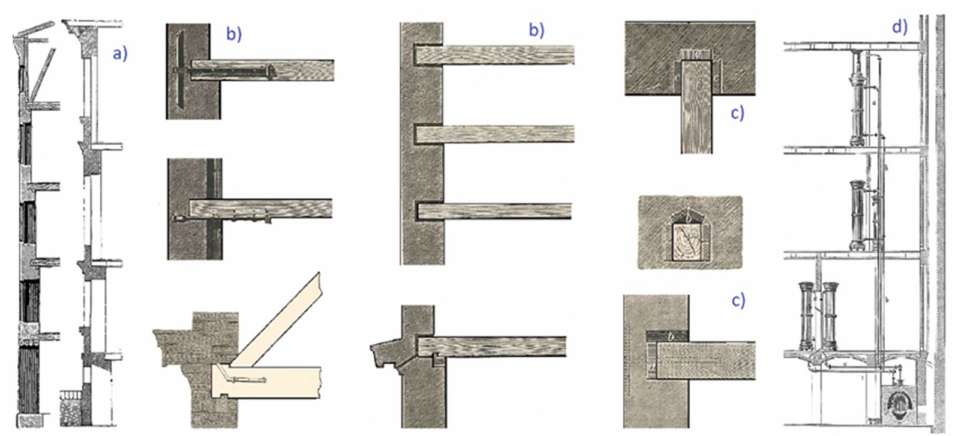
Figure 2. Principles of anchoring floor beams in the walls of 19th century buildings: ( a ) wall cross- section, ( b ) details of setting the wooden beams ( c ) details of setting the wooden beams, ( d ) central heating installation (19th century), based on [88].